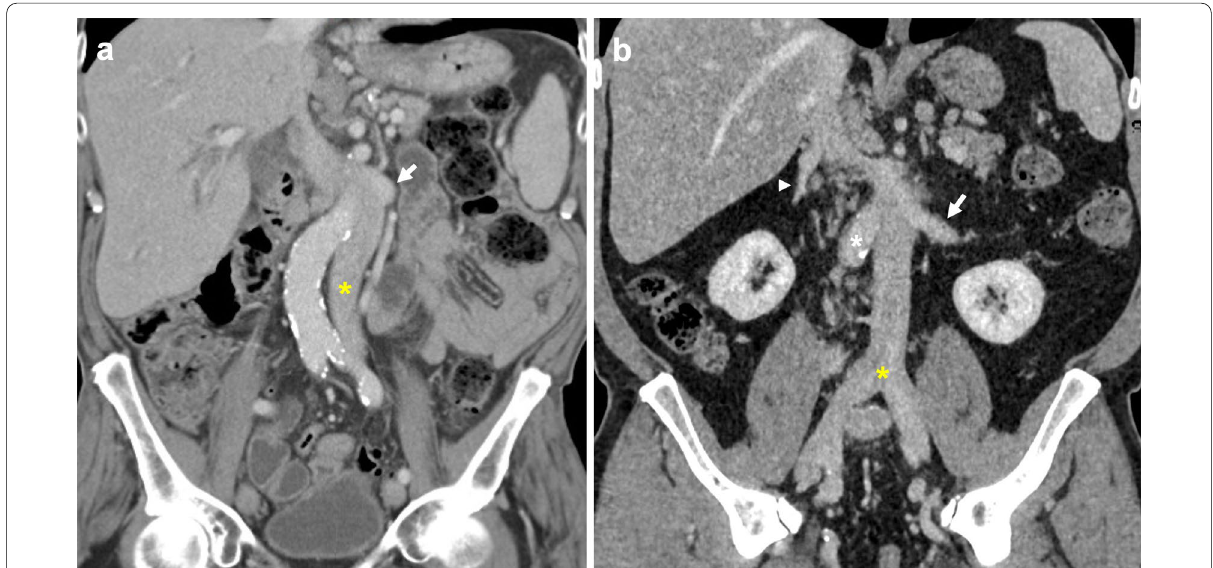
Fig. 6 Left-sided IVC. a Coronal CT image shows a non-enhanced left-sided IVC (asterisk) draining into an enhanced left renal vein which connects to the hepatic IVC. b Coronal CT image of a second case demonstrates a typical confluence of common iliac veins (yellow asterisk) forming the infrarenal IVC on the left side of the aorta (white asterisk) to join the left renal vein (arrow) which drains into the orthotopic IVC. The proximal right renal vein (arrowhead) is also pictured draining into the suprarenal